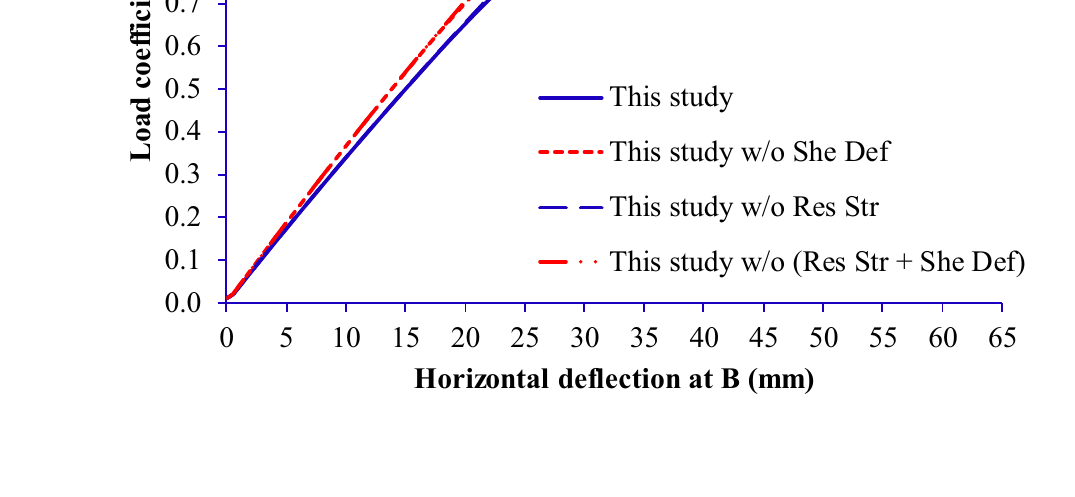
Fig. 19 Load-vertical deflec- tion relationship at B of six- story